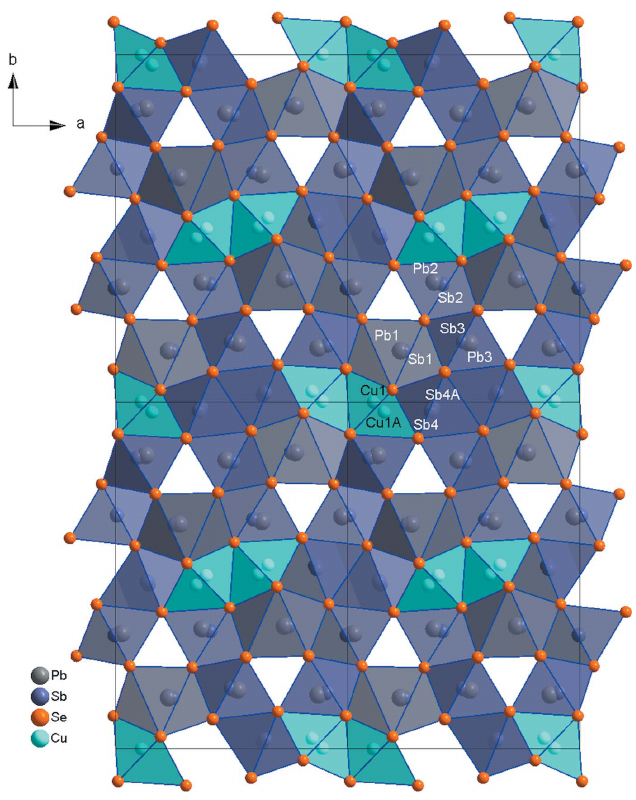
Figure 2 Graphical comparison of the two different coordination polyhedra of Sb3 and Pb3. Colours as in Fig.